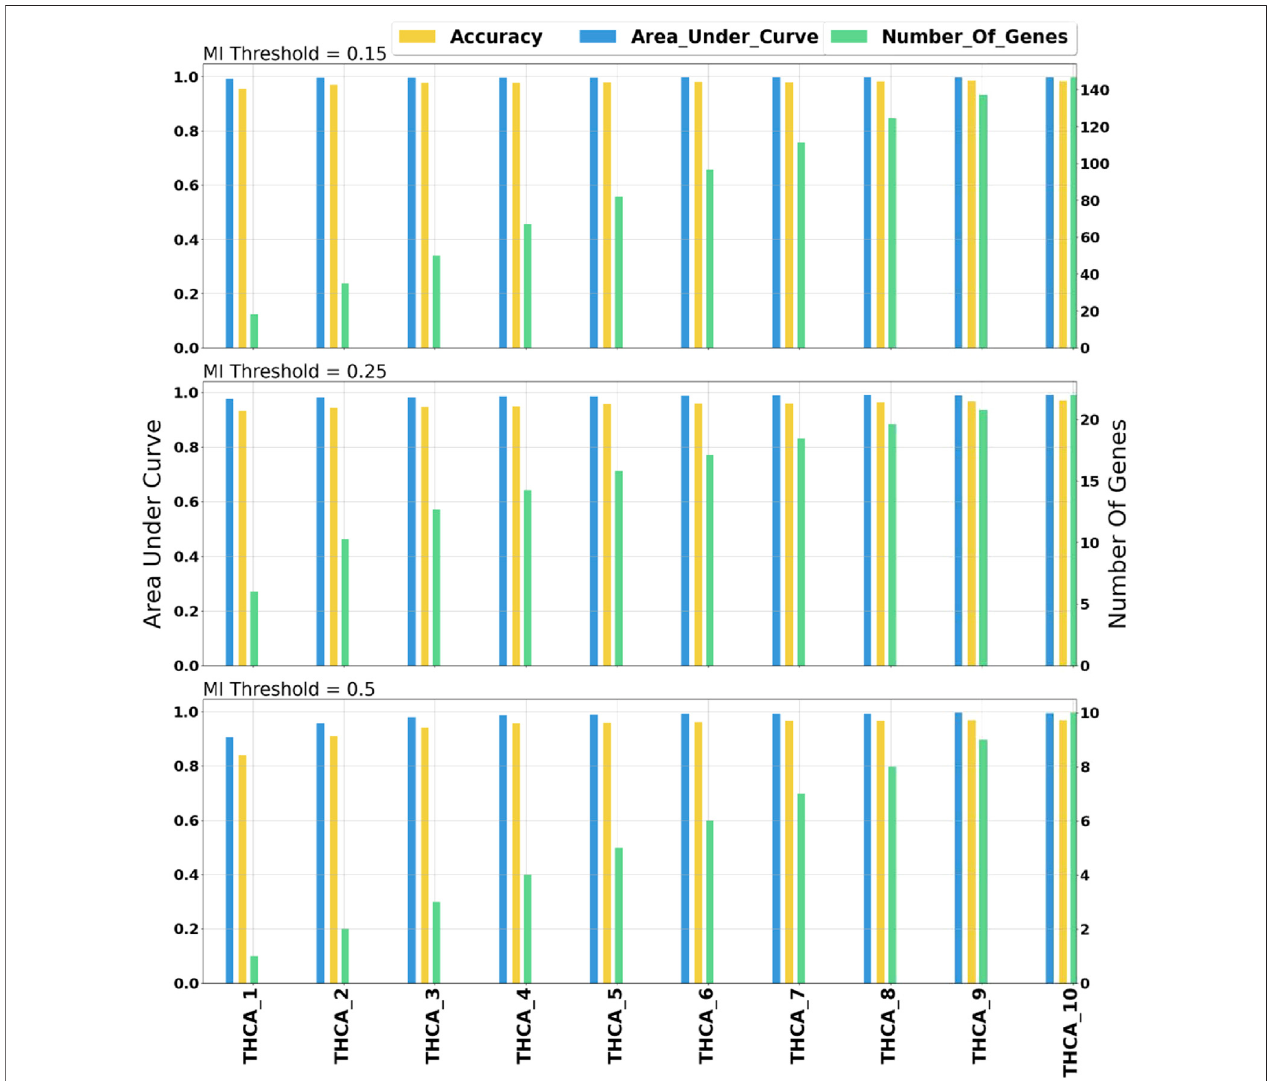
FIGURE6| Comprehensiveevaluationofdifferentmutualinformationthresholdvalues.Thenumbersfollowingtheunderscorevaluescorrespondtothenumberof groups.